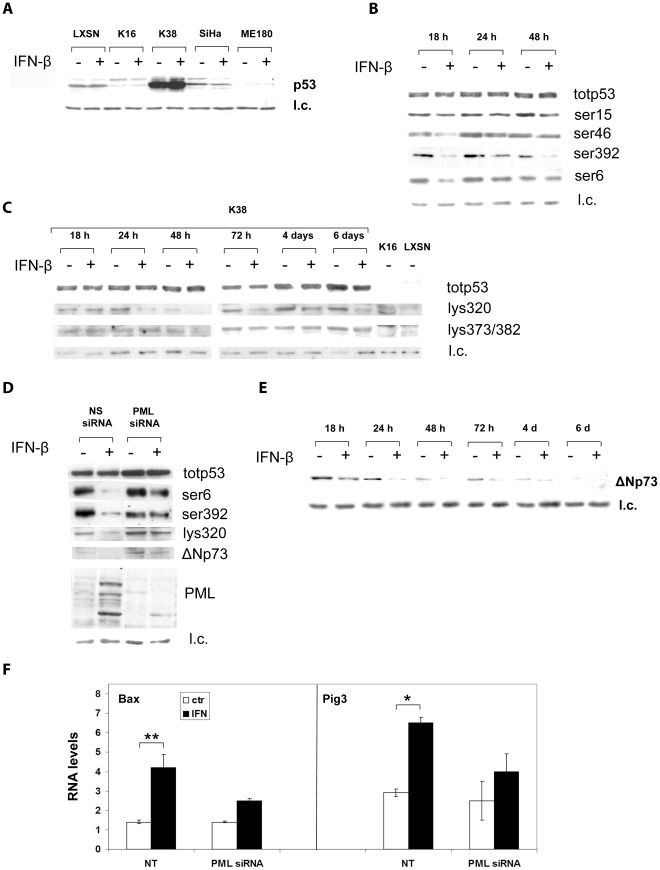
IFN-β effect on p53 post-translational modification and expression of its target genes.(A) WB analysis of p53 in control keratinocytes (LXSN), K16 and K38 cells and in high risk HPV-positive squamous carcinoma cell lines SiHa and ME-180 treated with IFN-β for 48 h. (B) WB analysis of p53 phosphorylated at different phosphorylation sites. (C) WB analysis of acetylated p53. (D) WB analysis of phosphorylated and acetylated p53 and ΔNp73 in K38 cells silenced by PML siRNA and treated with IFN-β for 48 h. (E) WB analysis of ΔNp73 in K38 cells treated with IFN-β for different time points. Whole cell extracts were resolved on SDS-PAGE and transferred onto PVDF membrane. Immunoblotting was performed as reported in M&M. (F) Real time PCR analysis of Bax and Pig3 was carried out on K38 cells treated with IFN-β for 48 h, also in the presence of PML siRNA. NT  =  not transfected. * = p<0.05; ** = p<0.01.